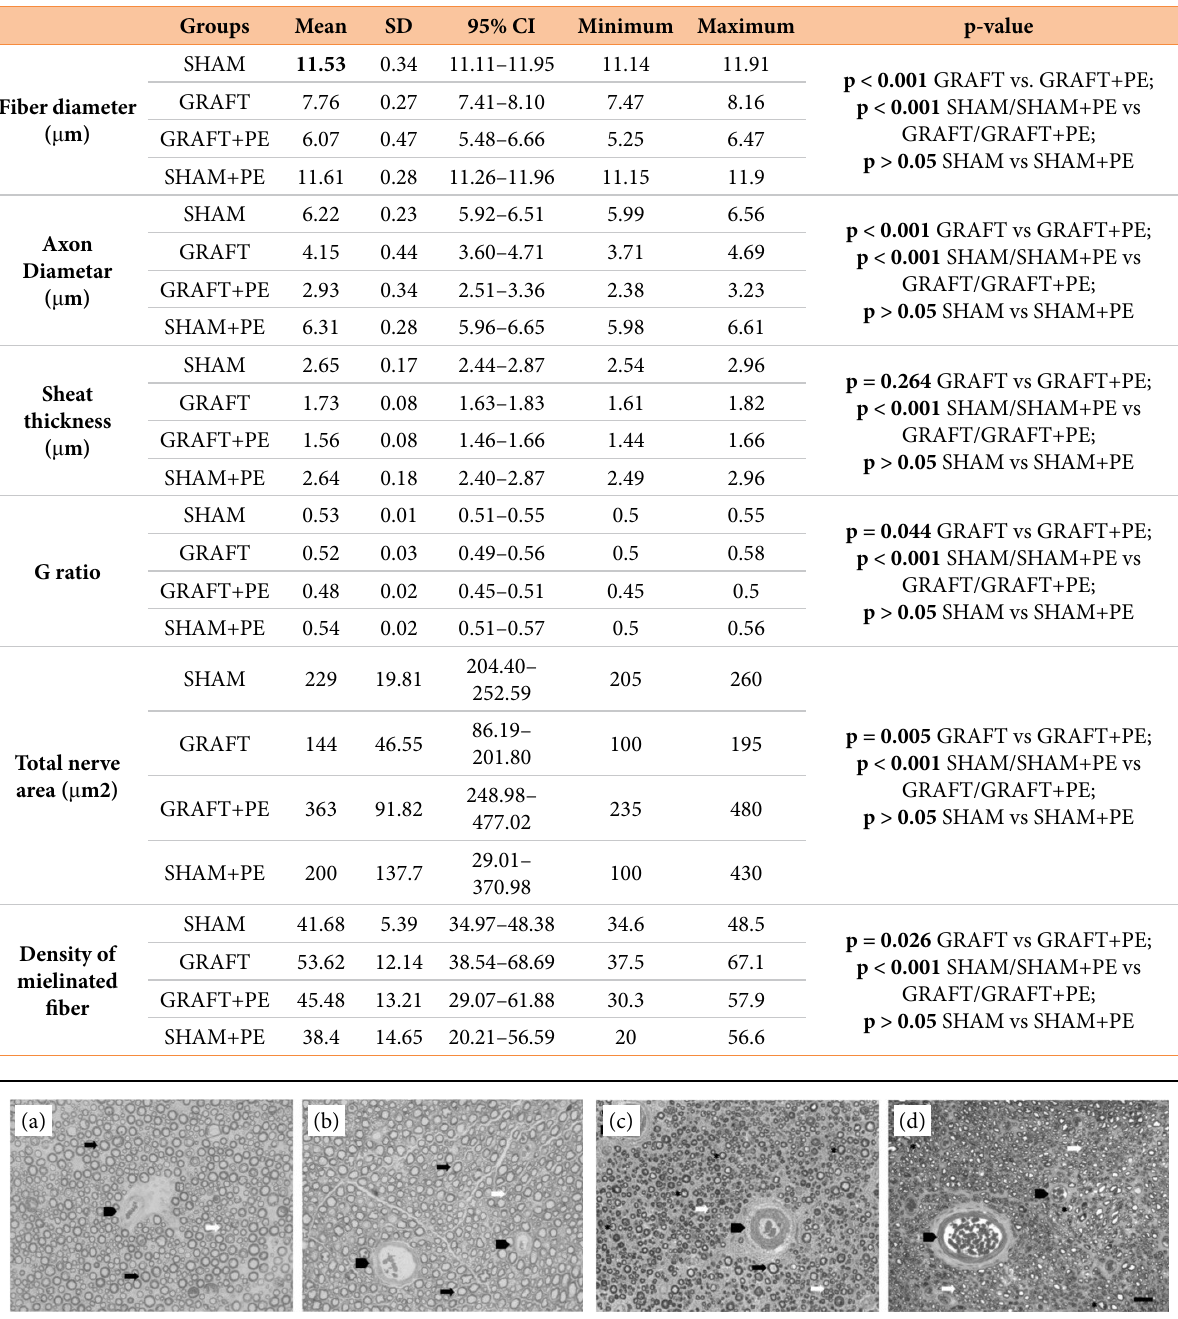
Table 2 - Results of morphometric variables among the groups.